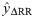
Cardiac responses to different combinations of VNS parameters, estimated with a Gaussian process regression for sheep 1.The chronotropic (y^ΔRR), dromotropic (y^ΔPR) and inotropic (y^dPdtmax) responses are shown in the first, second and third rows, respectively. Note the different scales of each colormap. The continuous black line represents a reference threshold of 5% variation with respect to the baseline value.